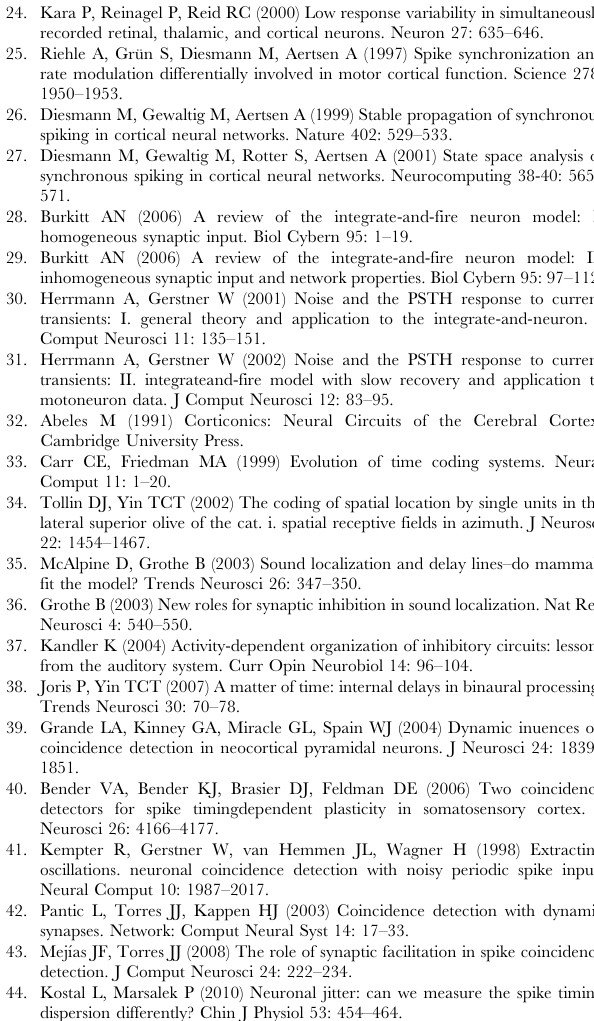
Figure 9. ISI-distance as a function of the time windows T w and the threshold h of the CD neuron under the pulse input. (A) D s function of T w and h . There exists a clear boundary for large and small D s h and T w dependence of D s , respectively. The parameters are N ~ 100 , V th ~{ 40 mV, V r ~{ 65 mV, t m ~ 10 ms, and D ~ 20 mV/ms. M